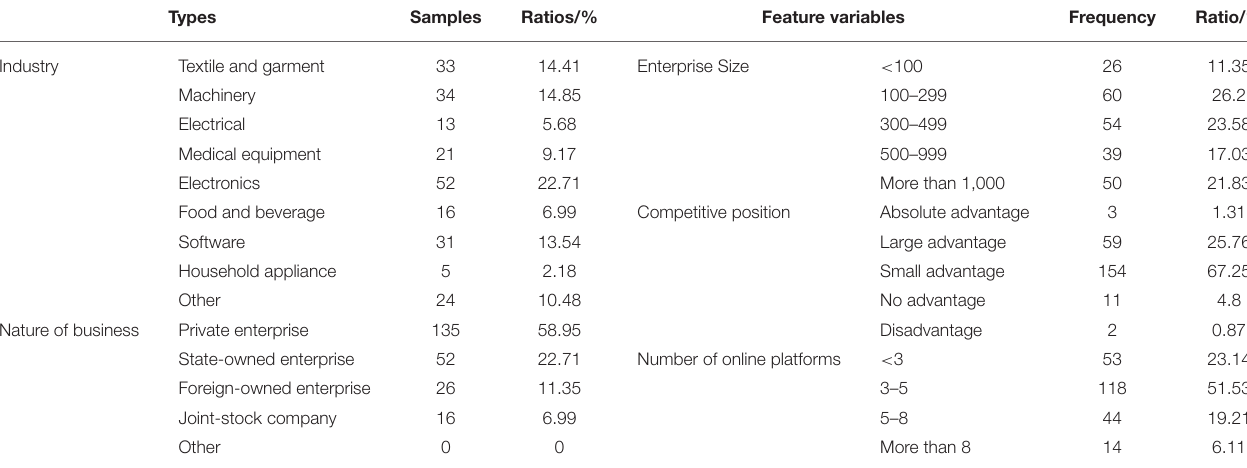
TABLE 1 | Sample distribution